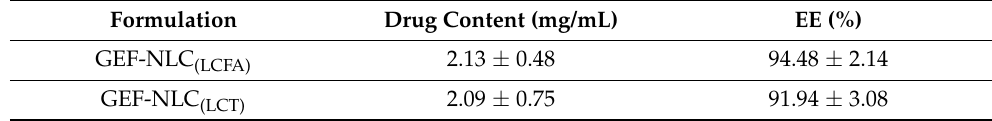
Table 6. Drug content and EE% of GEF-NLC (LCFA) and GEF-NLC (LCT)